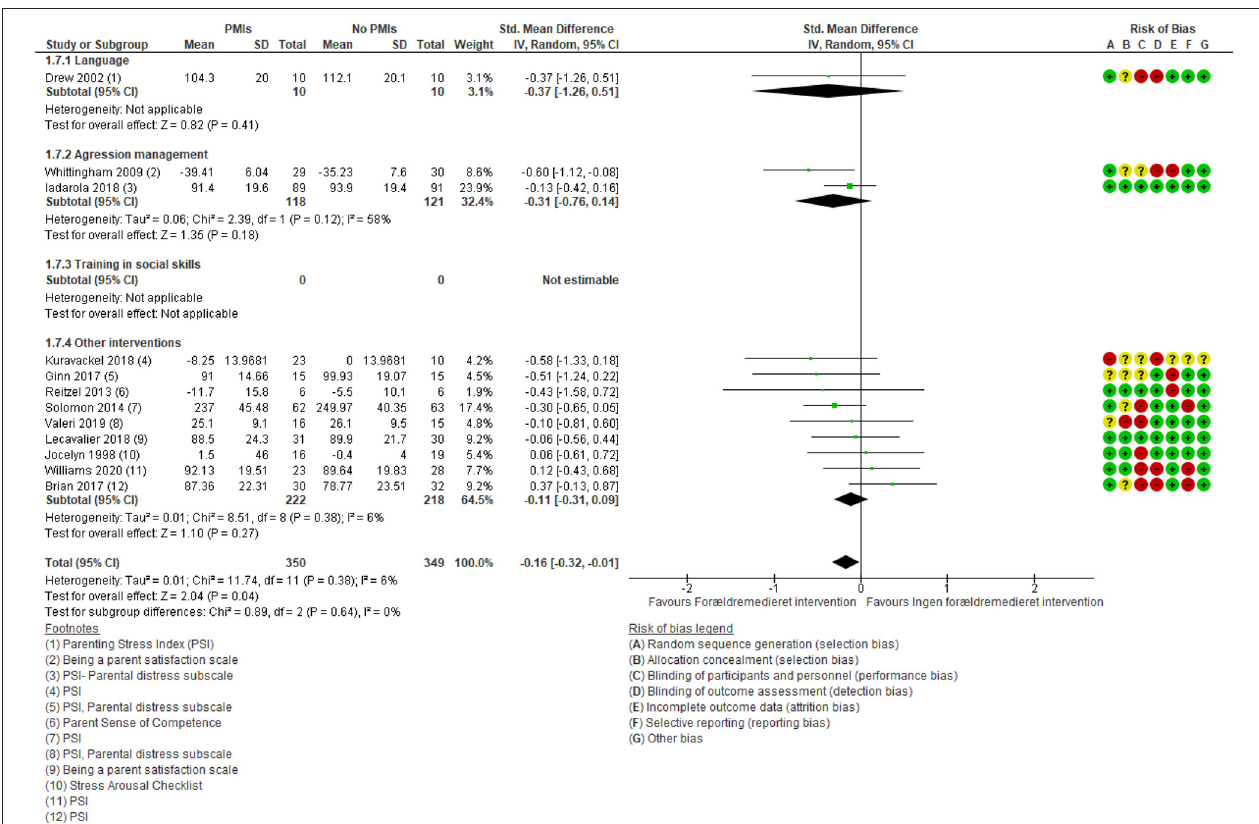
FIGURE 10 | Forest plot of comparison: PMI vs. no PMI intervention, outcome: parental